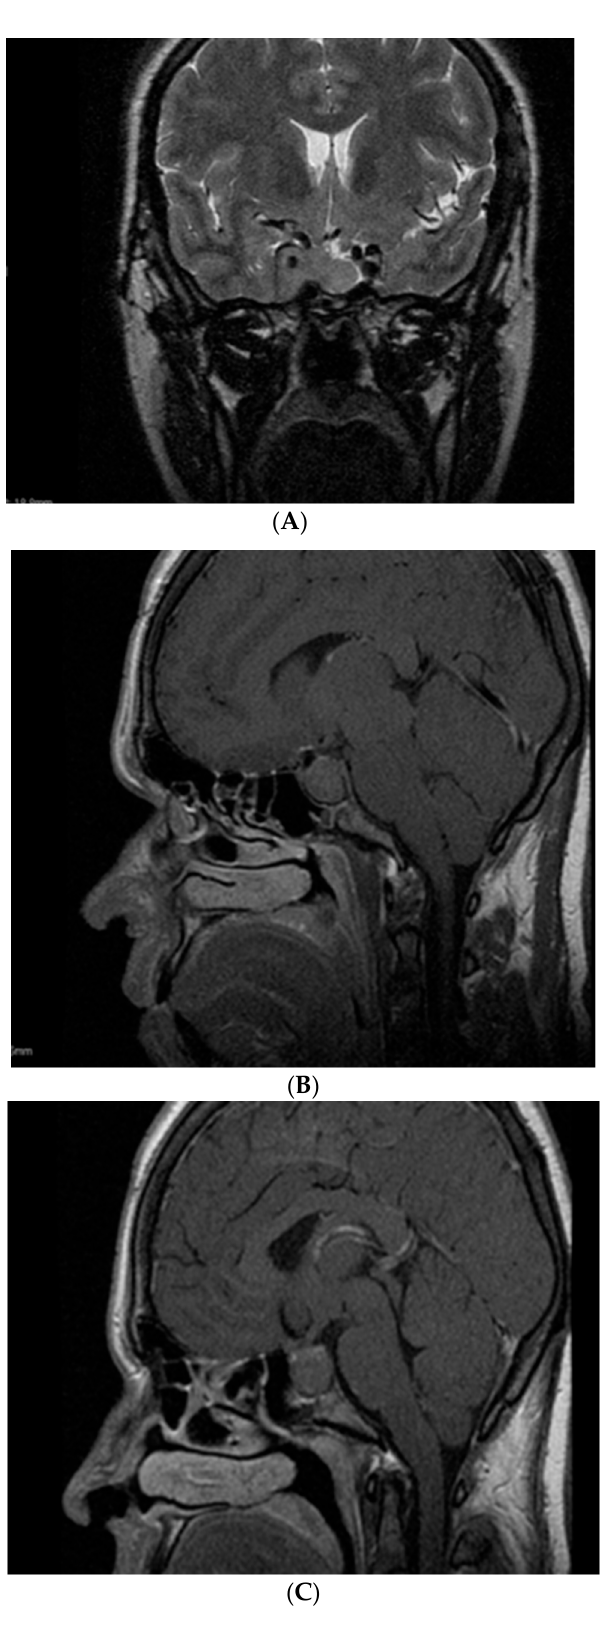
Figure 3. Magnetic resonance imaging of the somatotropinoma (2.4 by 3.3 by 2.5 cm) at initial di- agnostic. ( A ) Coronal post-contrast aspect. ( B ) Sagittal post-contrast aspect. ( C ) Post-operatory as- pect (2 months since selective trans-sphenoidal hypophysectomy)—a somatotropinoma of 2.4 by 3.1 by 2.2 cm.